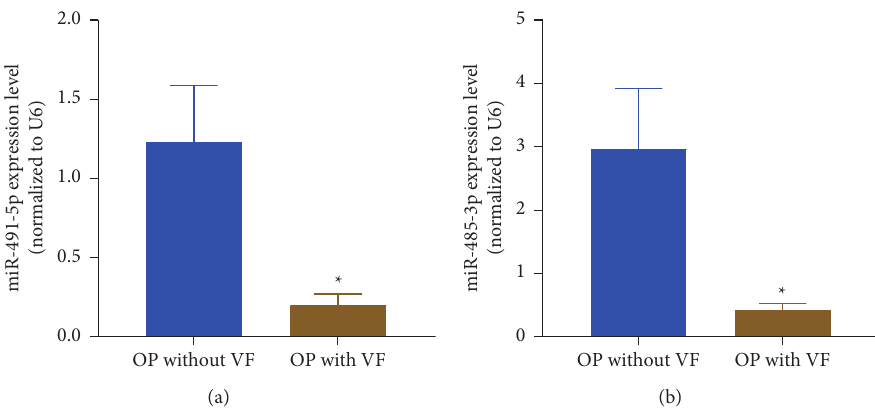
Figure 2: The expression levels of miR-491-5p and miR-485-3p in plasma of osteoporotic patients with or without vertebral fractures. ∗ P < 0.001 compared with osteoporotic patients without vertebral